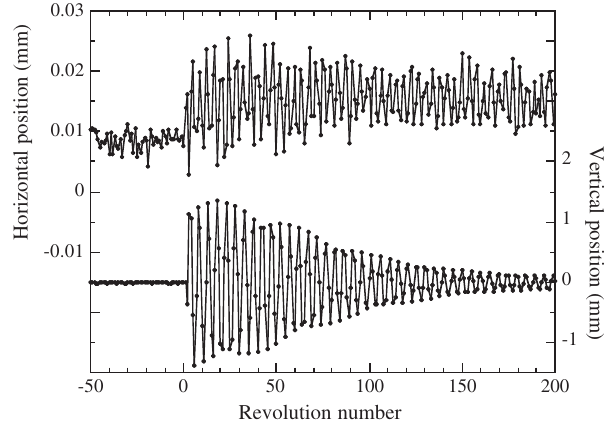
FIG. 2. A typical turn-by-turn beam position in the horizontal (above) and the vertical (below) direction. The deflection took place after the revolution number 0. The vertical oscillation damped because of the chromatic Landau damping. The main component of the horizontal movement after the deflection was horizontal betatron oscillation.